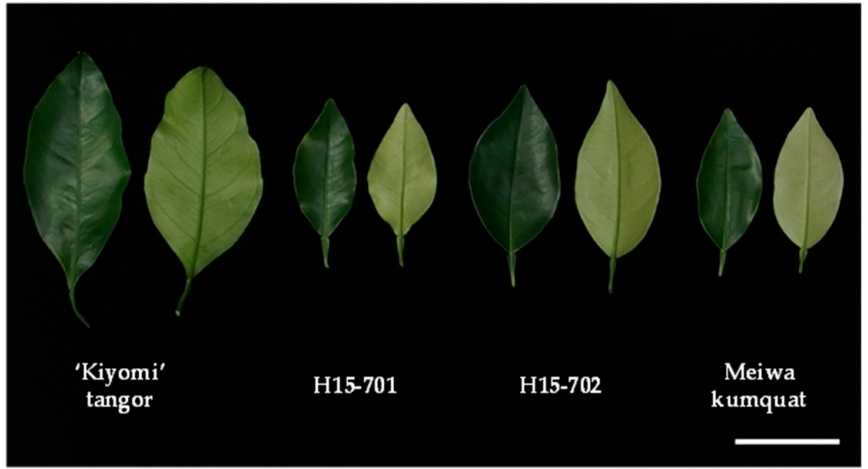
Figure 7. Comparison of morphological characteristics of leaves in ‘Kiyomi’ tangor, Meiwa kumquat, and their hybrids. (Bar = 5.0 cm).